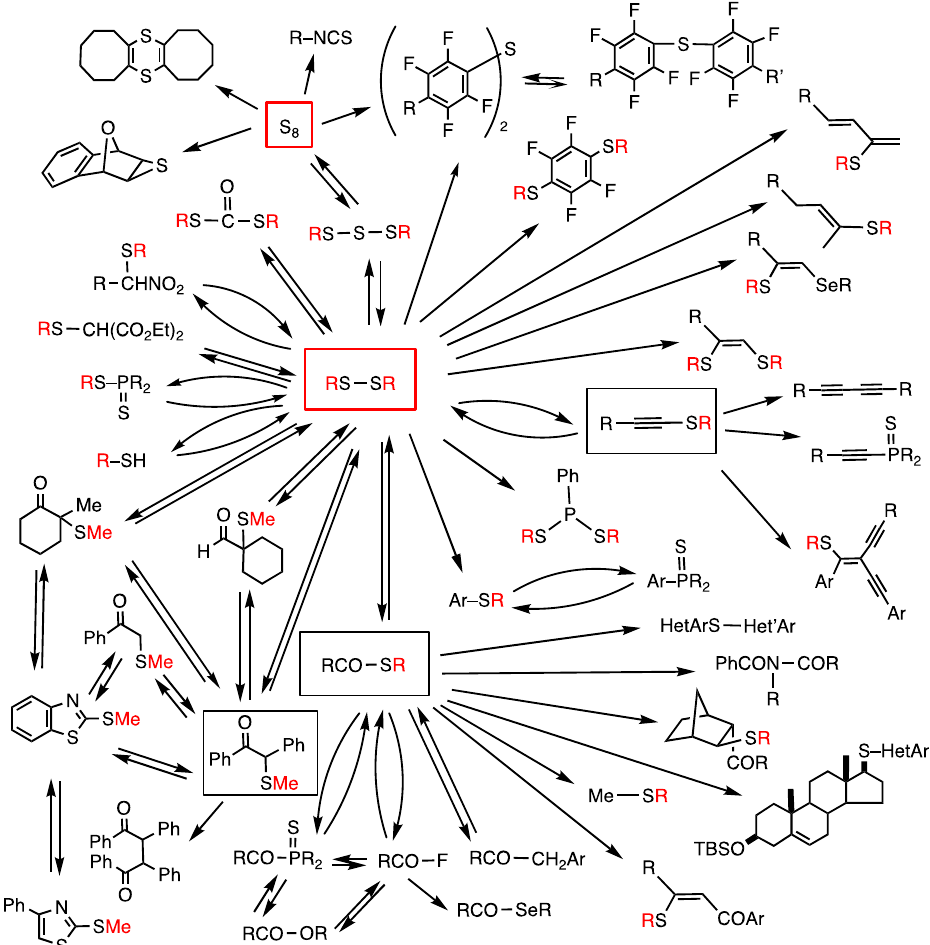
Figure 9. Schematic presentation of a rhodium-catalyzed chemical reaction network using disulfide and sulfur. Straight arrows pointing in opposite directions show chemical equilibria in closed systems, and curved arrows pointing in opposite directions show interconversion reactions in open systems. Red R letters are derived from organic groups in disulfides. Squares contain important synthetic intermediates.